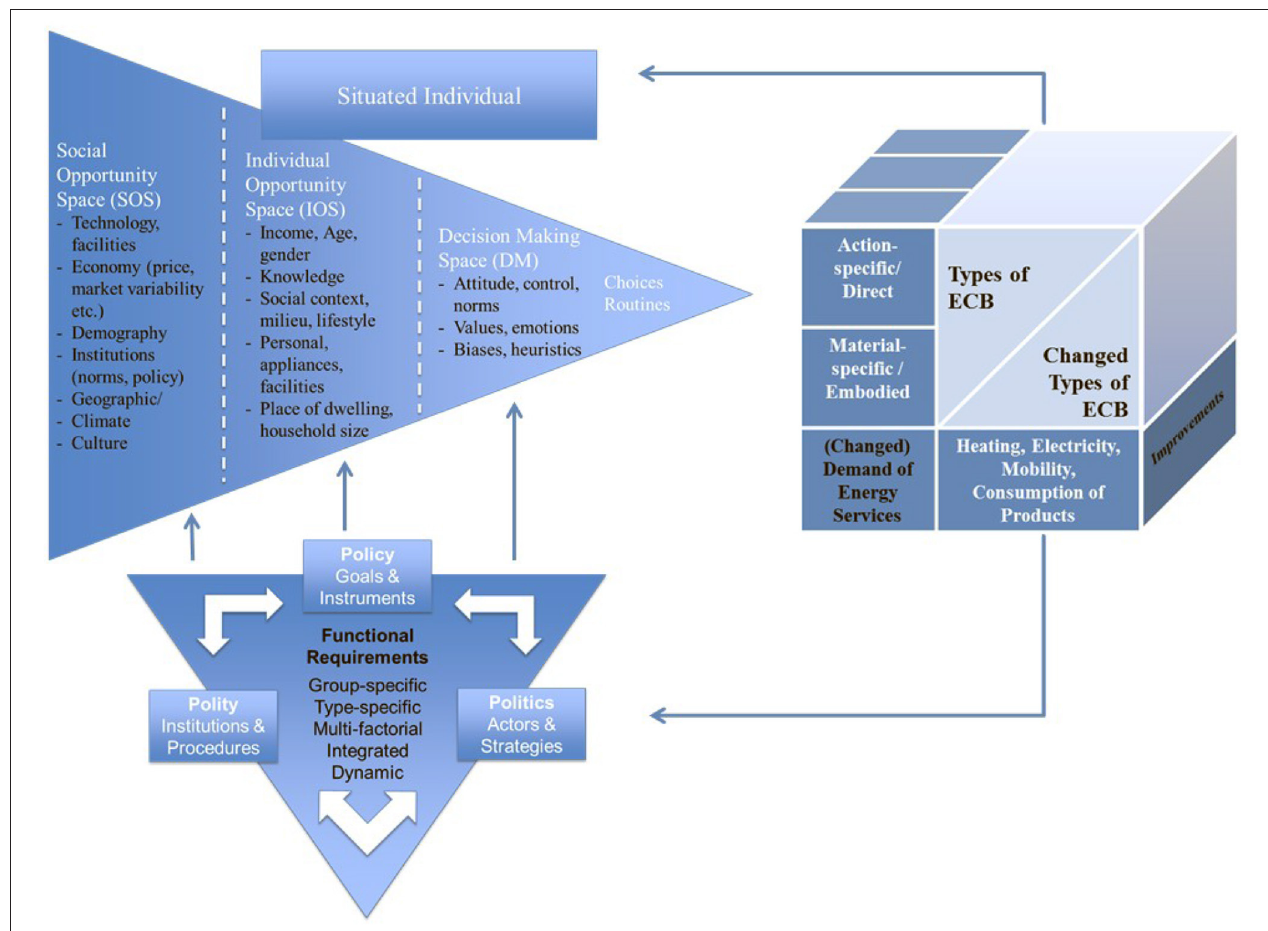
FIGURE 1 | The integrated HH energy consumption framework (IHECF, reproduced from Burger et al.,